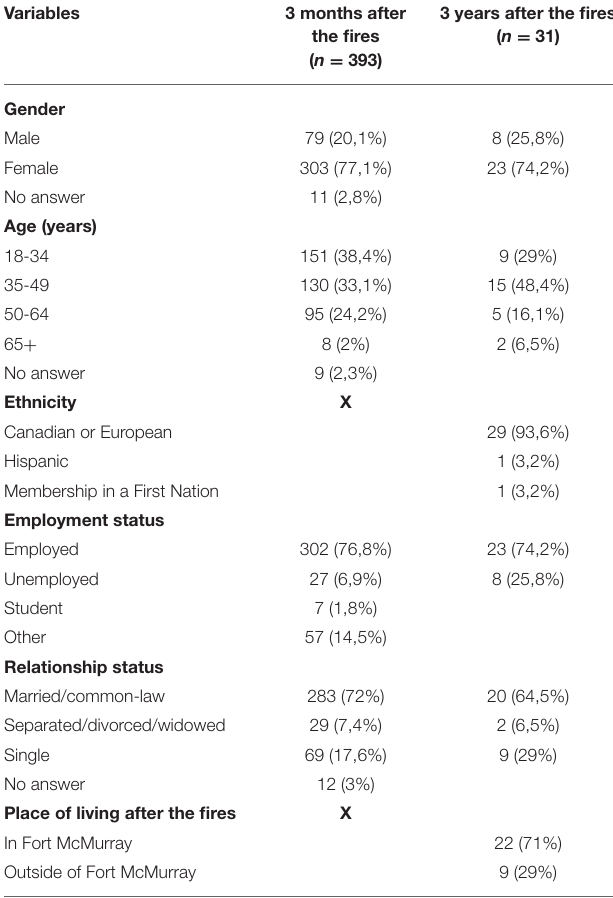
TABLE 1 | Sociodemographic characteristics of